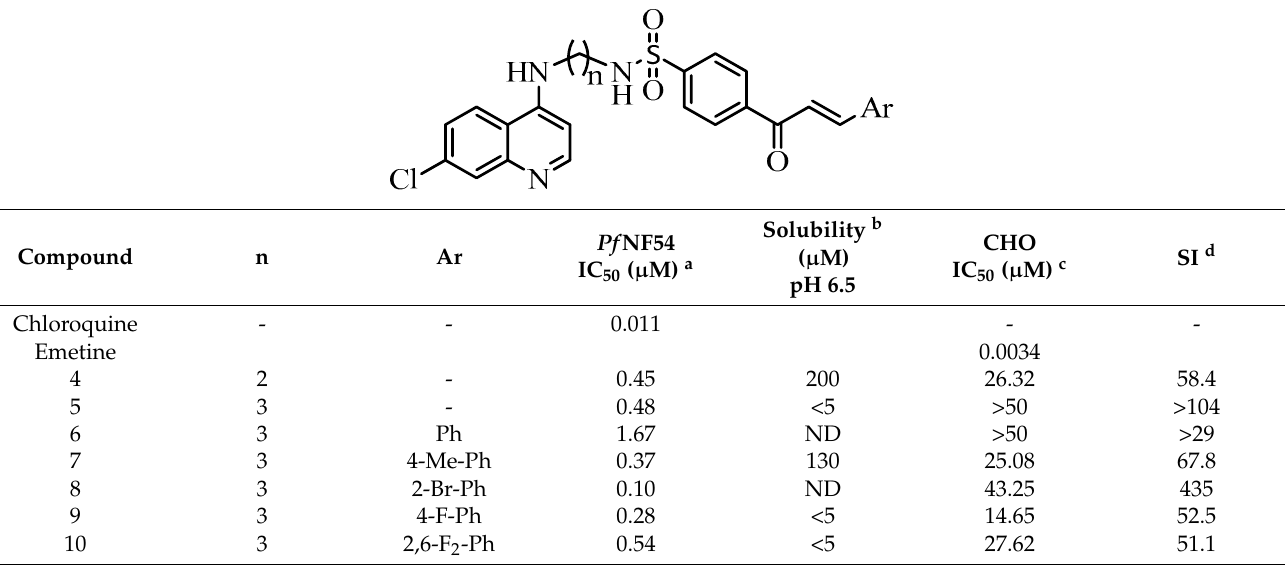
Table 1. Hybrid compounds with isolated yields.